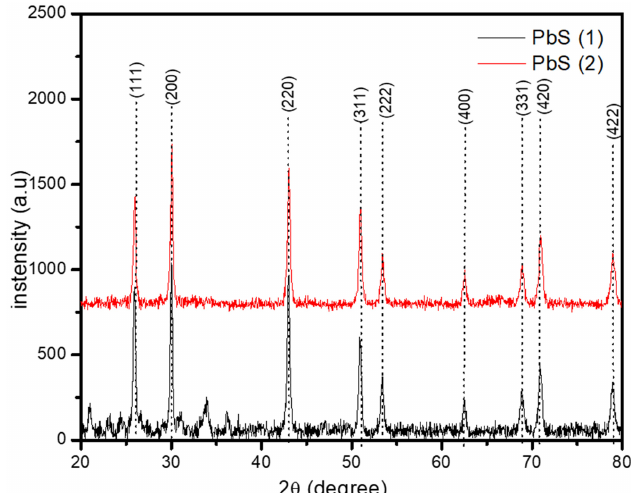
Figure 1. X-ray Diffraction (XRD ) patterns of PbS synthesized from 1, 10 phenanthroline lead(II) Figure 1. X-ray Di ff raction (XRD ) patterns of PbS synthesized from 1, 10 phenanthroline bis( N -alkyl- N -phennyl dithiocarbamate) adducts.